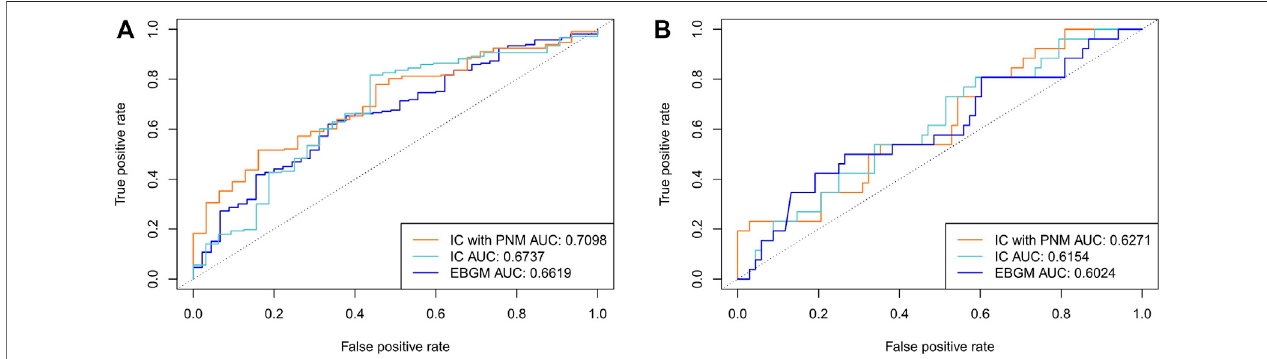
FIGURE 2 | (A) Comparison of performances of IC PNM , IC, and EBGM with SIDER data as the testing set using FAERS 2004 – 2009 data (B) Comparison of performances of IC PNM , IC, and EBGM with OMOP data as the testing set using FAERS 2004 – 2009 data.